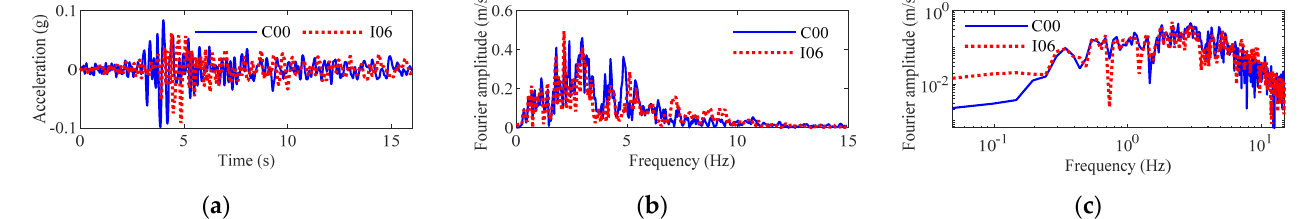
Figure 7. ( a ) Accelerations tested by SMART-1. ( b ) Fourier spectra of the accelerations. ( c ) Fourier spectra of the accelerations on a log-log scale.